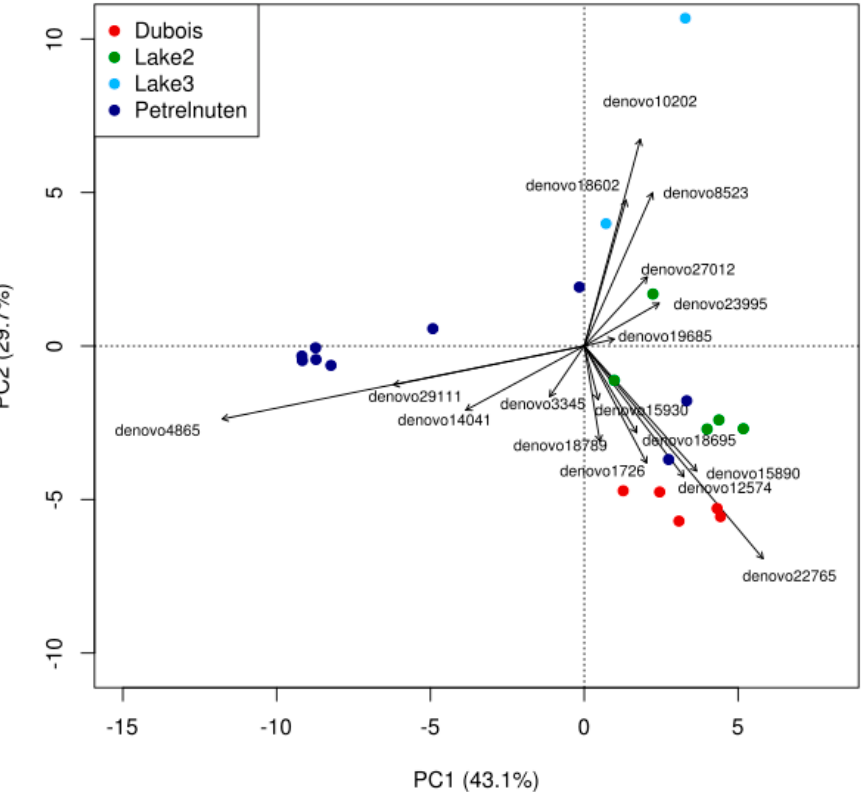
Figure 3. Principal component analysis of bacterial OTUs revealing compositional differences between sampling locations. The lowest possible level of taxonomic identification varied strongly between OTUs and in the majority of cases could only be resolved down to the family level. Full details of the OTU identities can be found in Table S4.